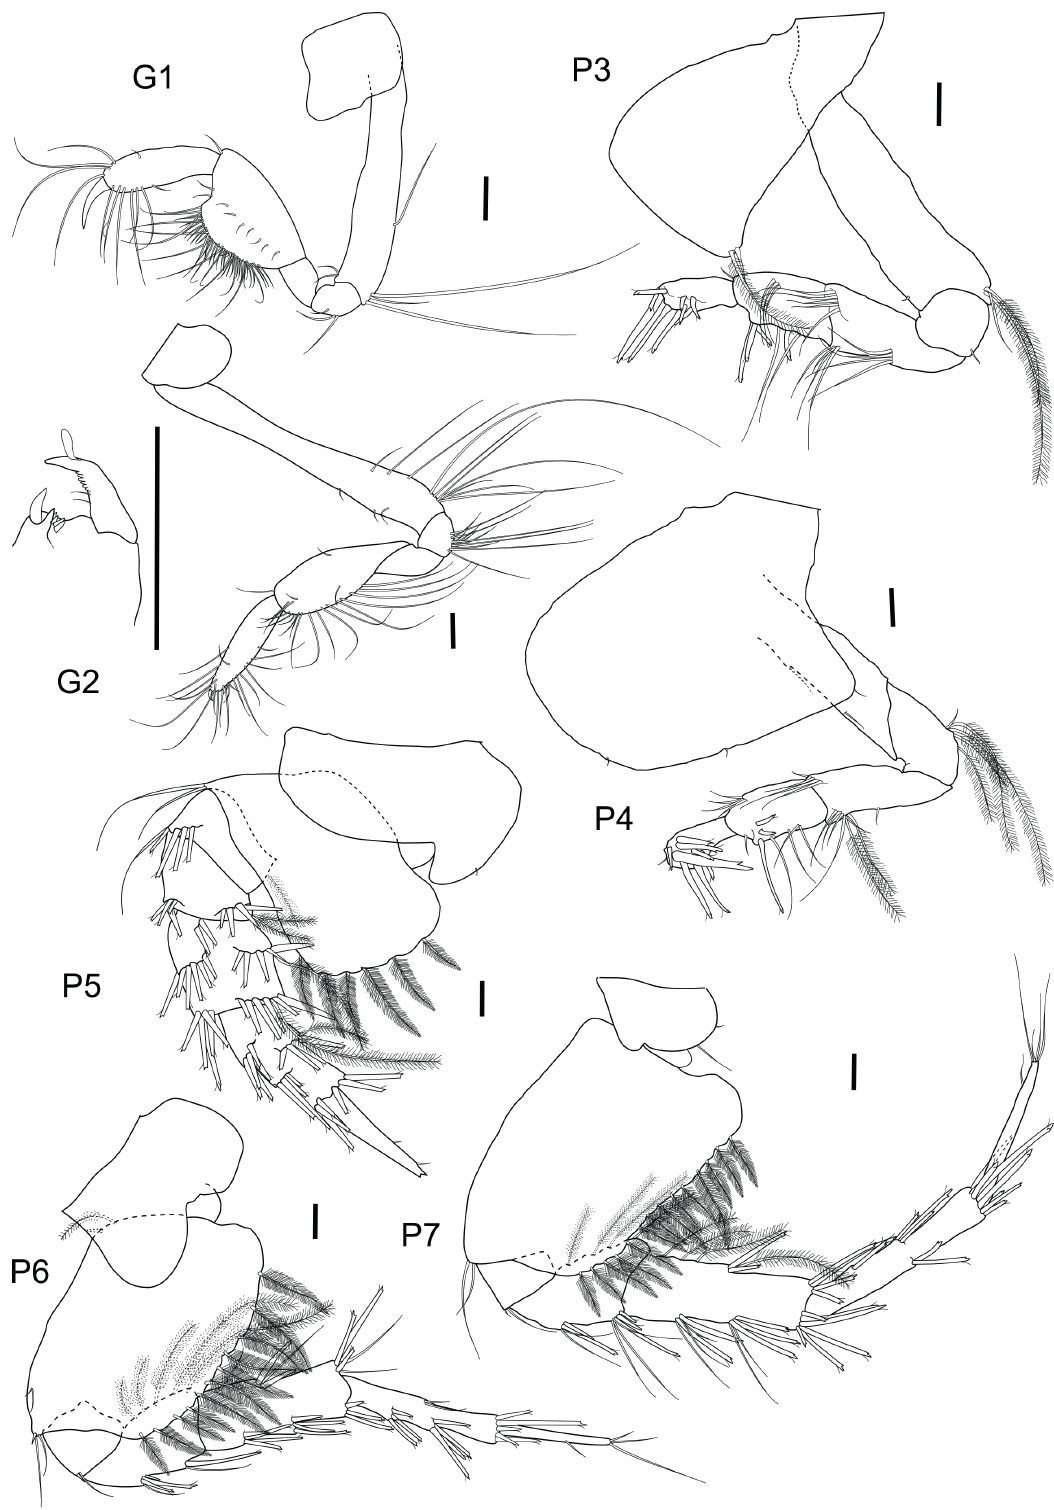
Figure 10 - Puelche longidactylus sp. nov. Female, 5.0 mm, MNRJ 28746: Gnathopods and pereopods. Scales = 0.1